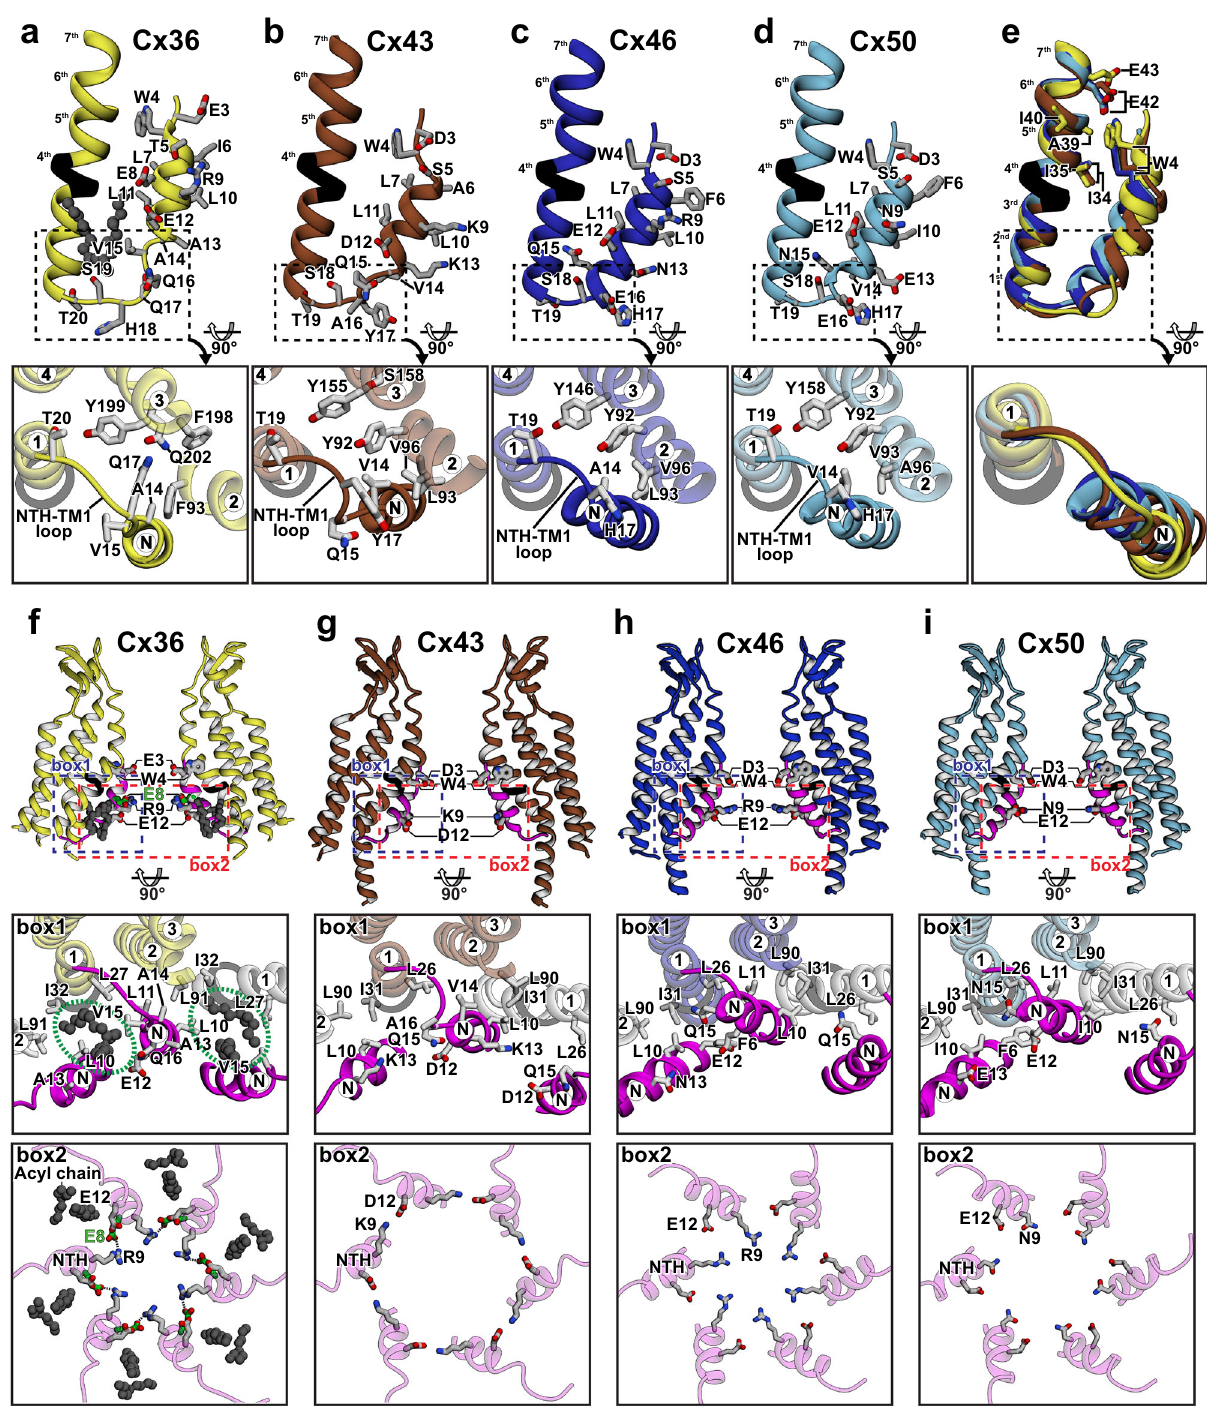
Fig.3|UniquestructuralfeaturesoftheCx36PLNstate.a – e Detailedstructures of NTHsand theNTH-TM1 loopsinCx36 ( a ), Cx43( b ), Cx46( c ),and Cx50( d ),and theirstructuralalignment( e ). f – i Ribbonrepresentationoftwofacingprotomersin Cx36 ( f ), Cx43 ( g ), Cx46 ( h ), and Cx50 ( i ) hemichannel regions. NTHs and acyl chains in the lipid-binding pockets are represented as magenta ribbons and dark gray ball-and-chain models, respectively. The detailed interactions in box 1 (blue dashed line) and box 2 (red dashed line) are represented in the bottom panels.